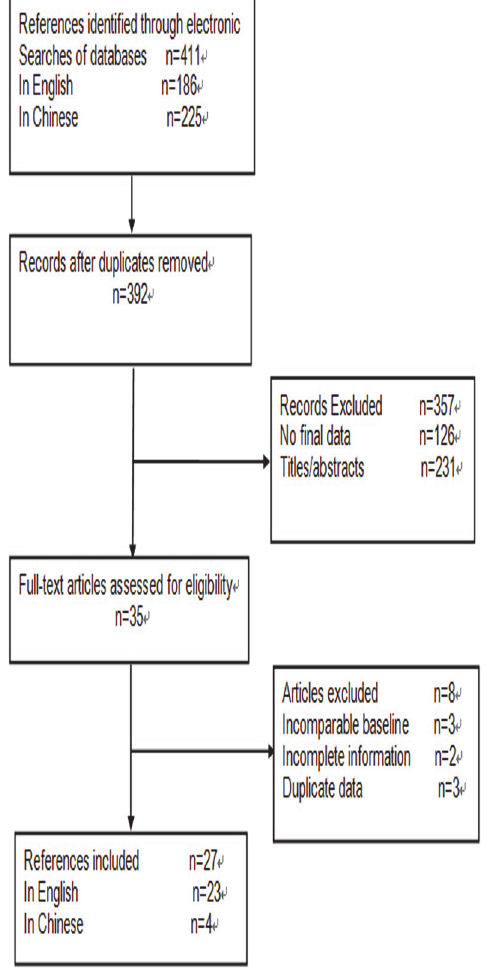
Fig 1. Flow diagram of study